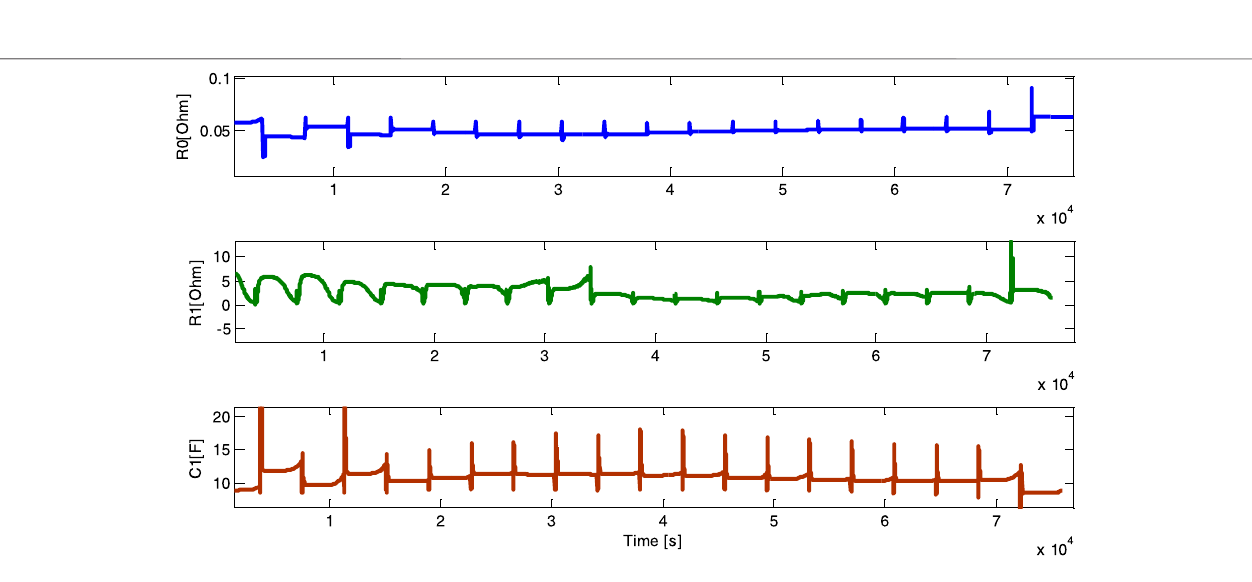
FIGURE 6 | 1RC-ECM parameters using RLS based on HPPC